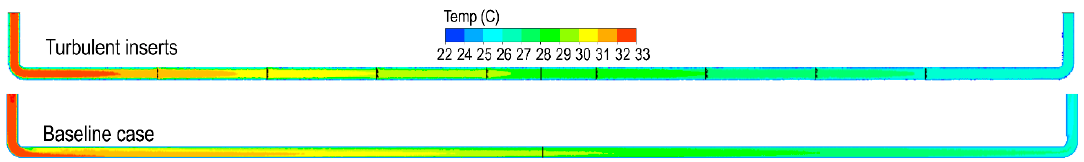
Figure 7. Temperature profile in the middle plane along the pipe for the two scenarios.